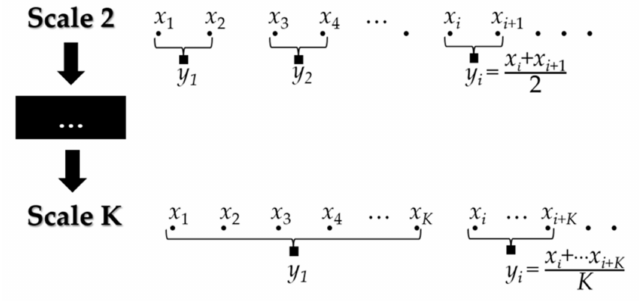
Figure 2. Example of the coarse-grained procedure from scale 2 to scale K